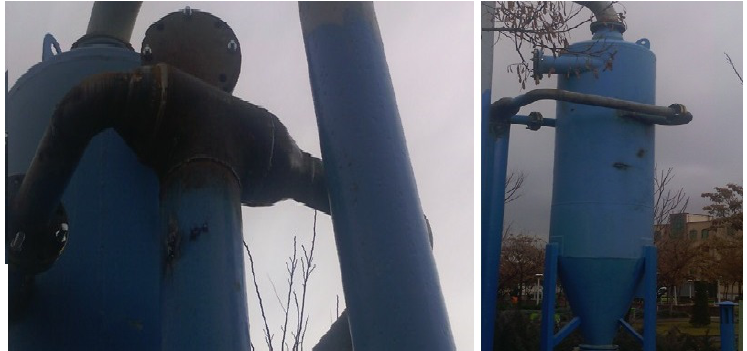
Fig. 5. Completion of the installation operation and change in the inlet